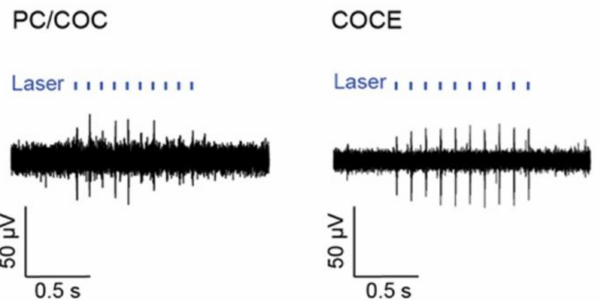
Figure 11. The figure shows the neural activity evoked by optical stimulation delivered through the PC/COC fiber (or COCE fiber) and recorded with the concentric AgNW mesh electrodes in a spinal cord of a Thy1-ChR2-YFP mouse. (Reprinted with permission from ref.